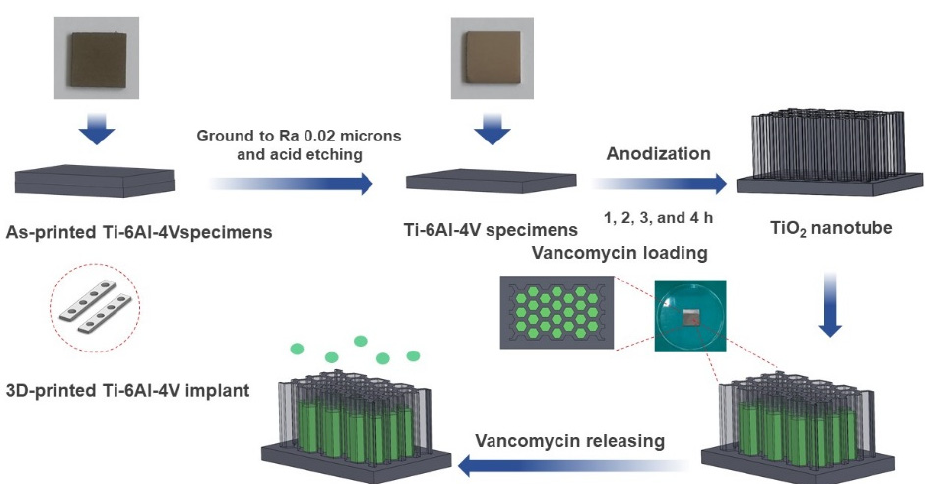
Figure 1. A schematic diagram depicting a stage-by-stage the vancomycin release protocol from the fabricated titania nanotubes surface on the 3D-printed Ti-6Al-4V implant material. The as-printed specimen was ground and chemically etched to a suitable roughness surface. The titanium oxide nanotubes (TNTs) were synthesized at different at anodization duration.